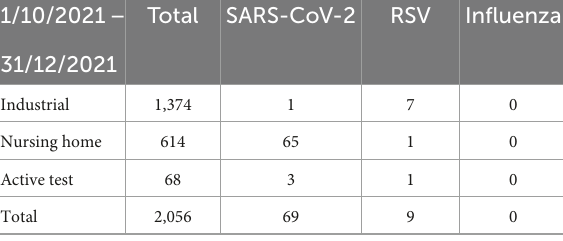
TABLE 2 Distribution of infections in each study group from January to September